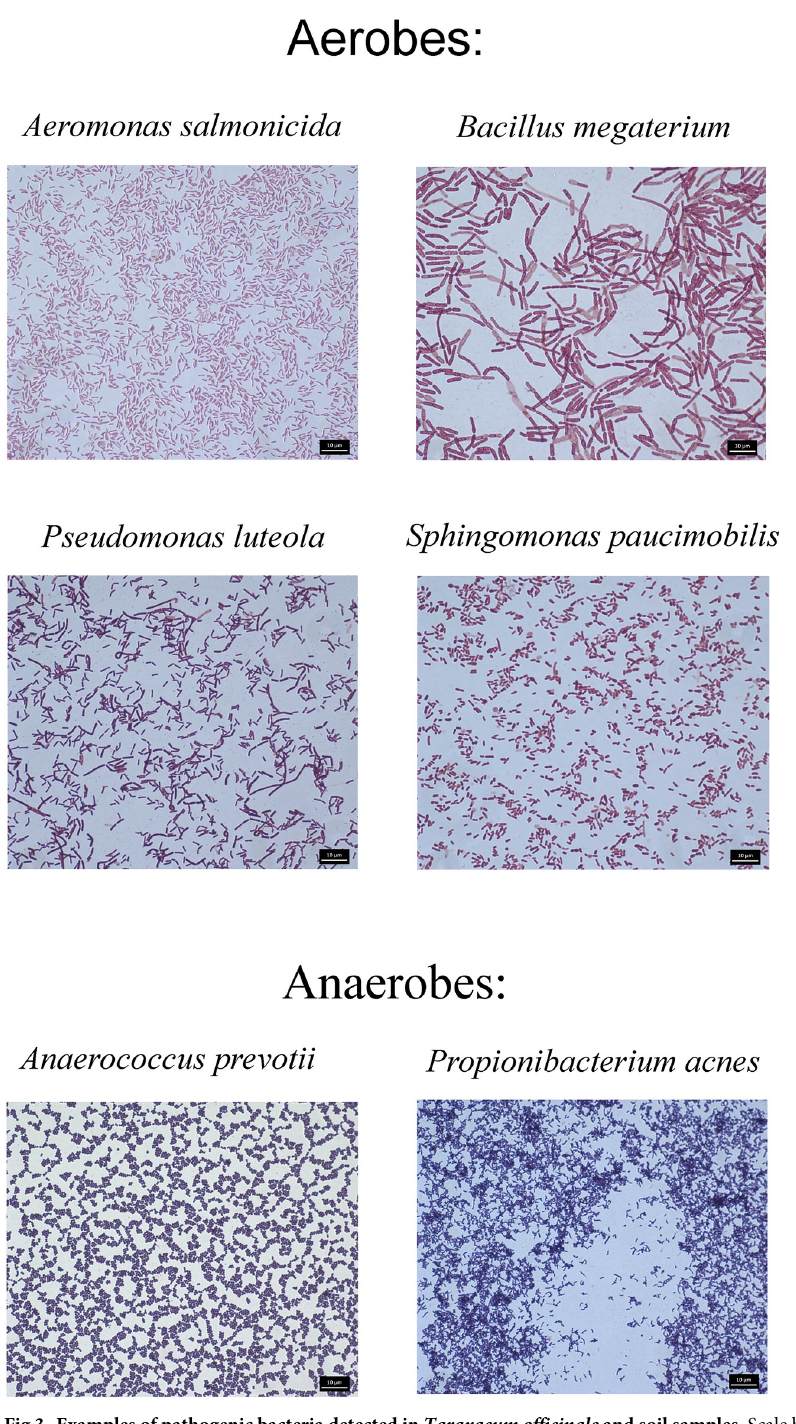
Fig 3. Examples of pathogenic bacteria detected in Taraxacum officinale and soil samples. Scale bars: 10 μ m.